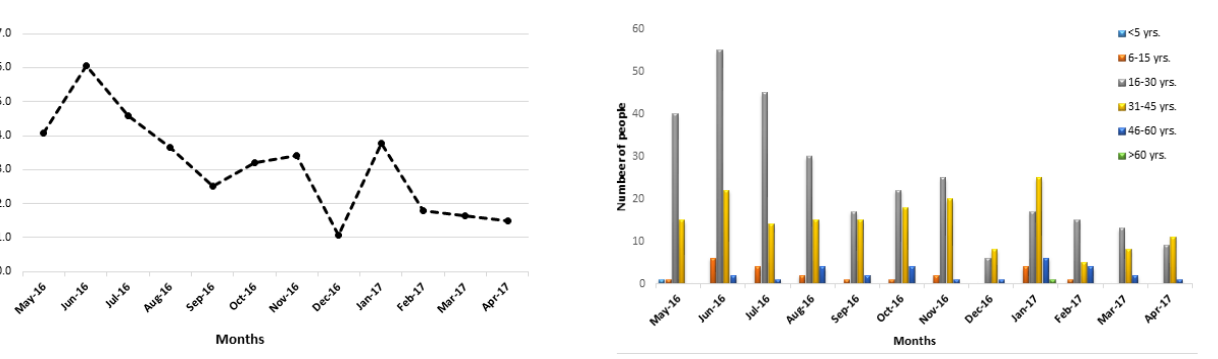
Figure 1 . Monthly Movement of People (in Percentages) to Non-malarious Areas (OS-O) for a Period of 1 Year.